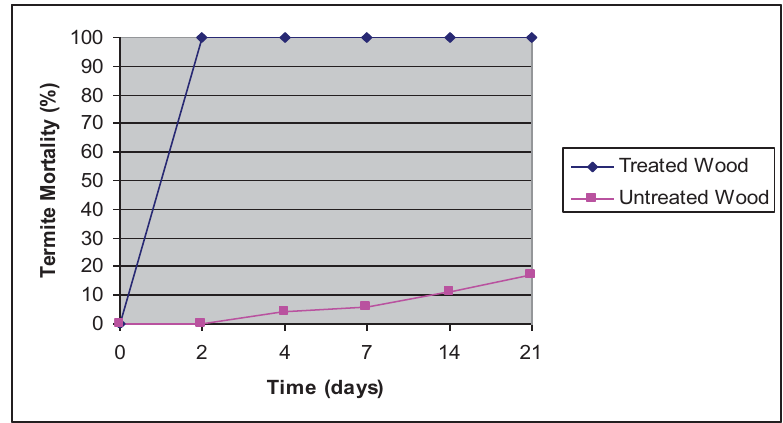
Figure 2. Termite mortality rate of essential oil